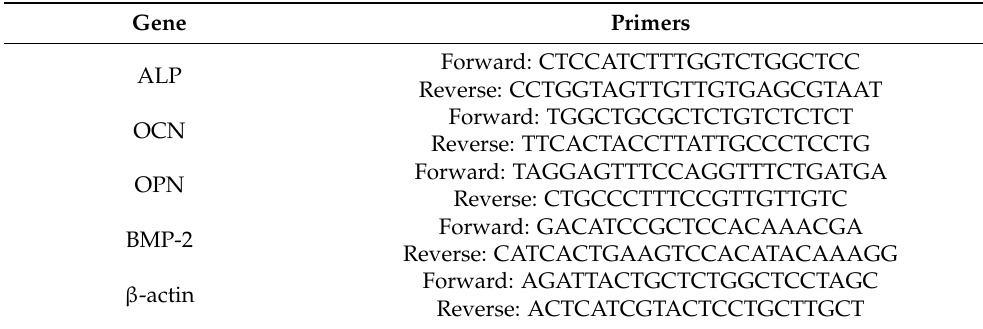
Table 1. Primer sequences used for RT-qPCR